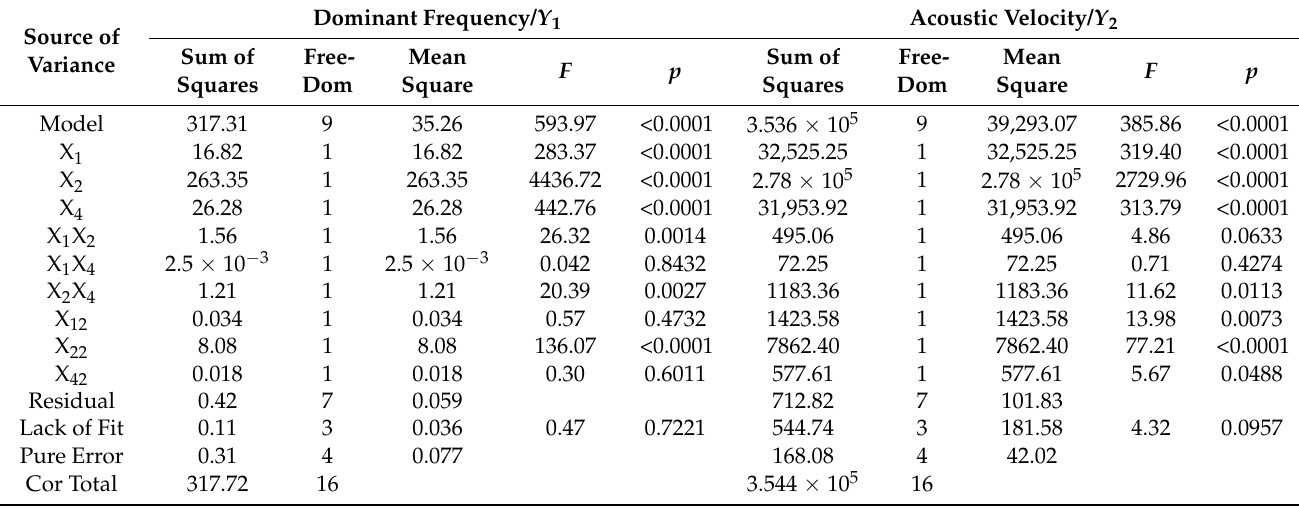
Table 9. ANOVA of Box—Behnken design quadratic